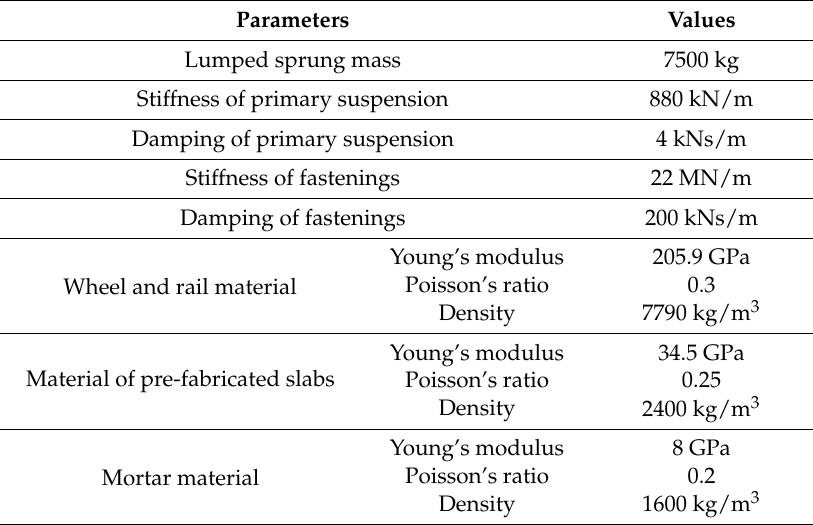
Table 1. Values of the parameters involved in this